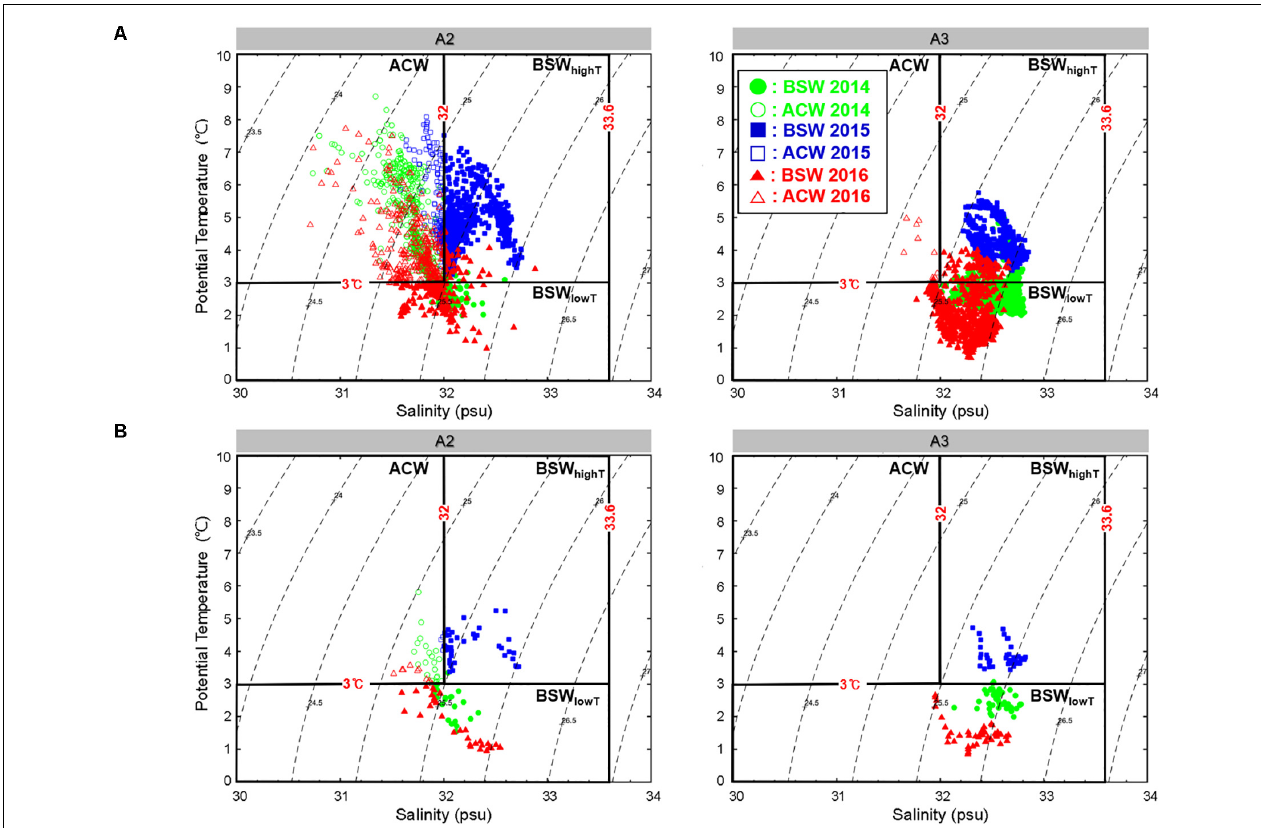
FIGURE 3 | A2 and A3 mooring T-S Diagram for 20 July–10. August 2014–2016 (A) Surface (B) Bottom. The shapes filled with color are BSW, and the shapes with no color are ACW (Green circles: 2014; Blue squares: 2015; Red triangles: